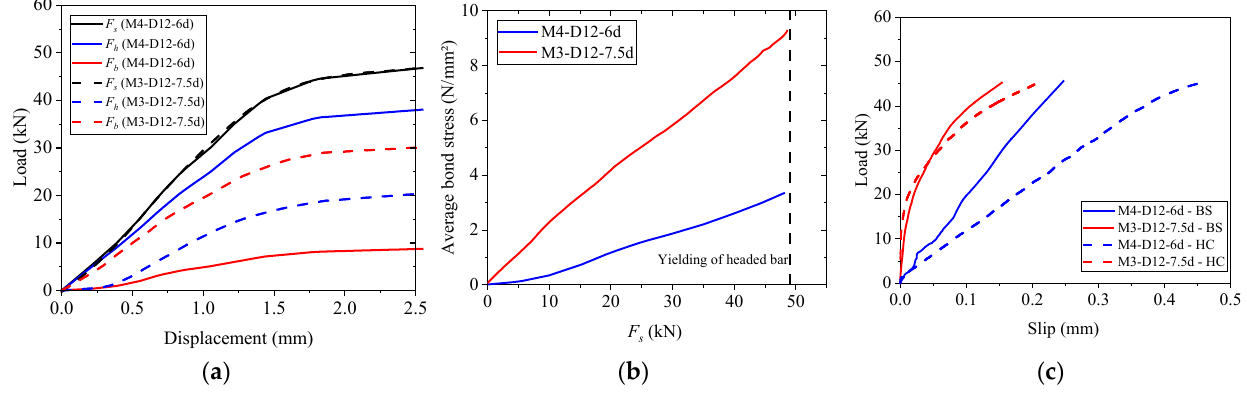
Figure 28. Comparison between specimen M4-D12-6d and M3-D12-7.5d ( a ) Distributive relationship; ( b ) Average bond stress; ( c ) Load–slip curve.